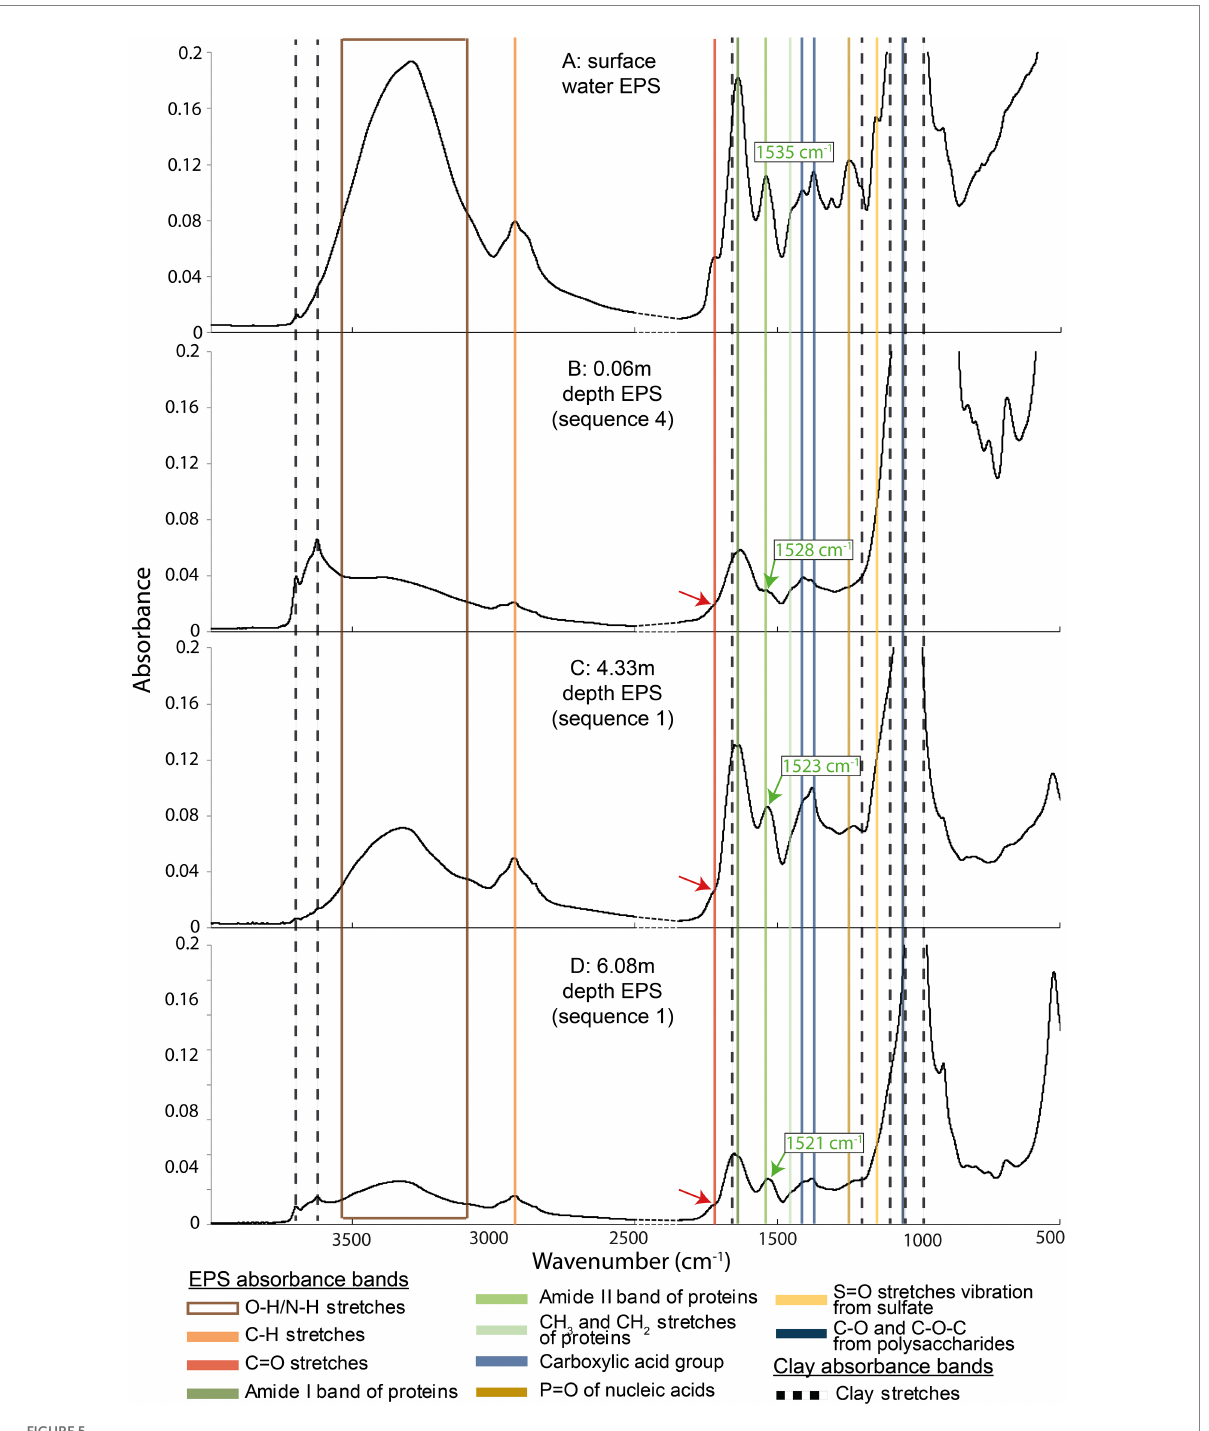
FIGURE 5 Fourier transform infrared spectroscopy spectra of four exopolymeric substances samples recovered from different depths along the BXN Long Core. Colored lines highlight the EPS absorption bands, while black dotted lines indicate clay mineral absorption bands. The red arrows show the position of the protonated carboxylic acid group stretches, which attenuate or disappear at a certain depth. Green arrows show the shift of the amide II